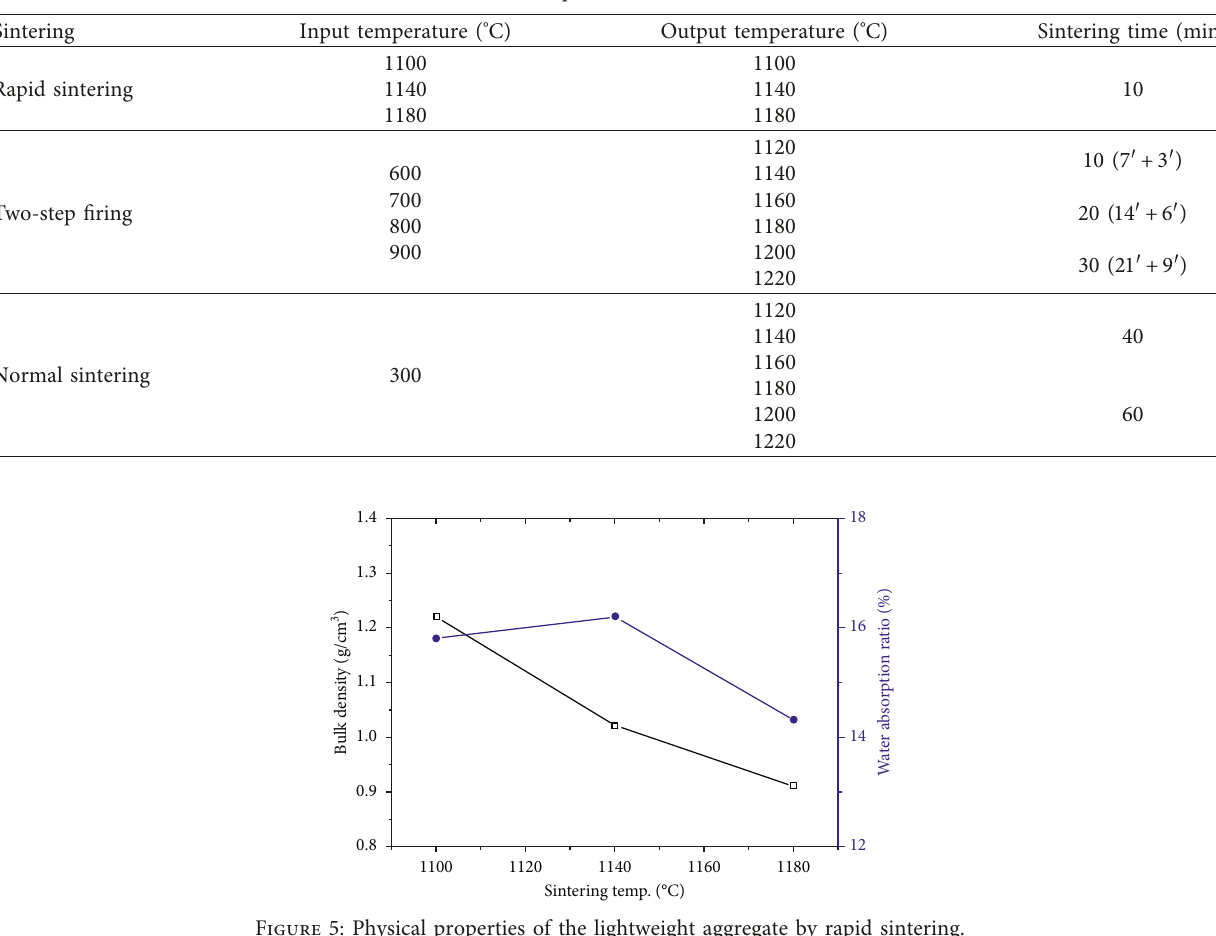
Table 3: Experimental conditions.